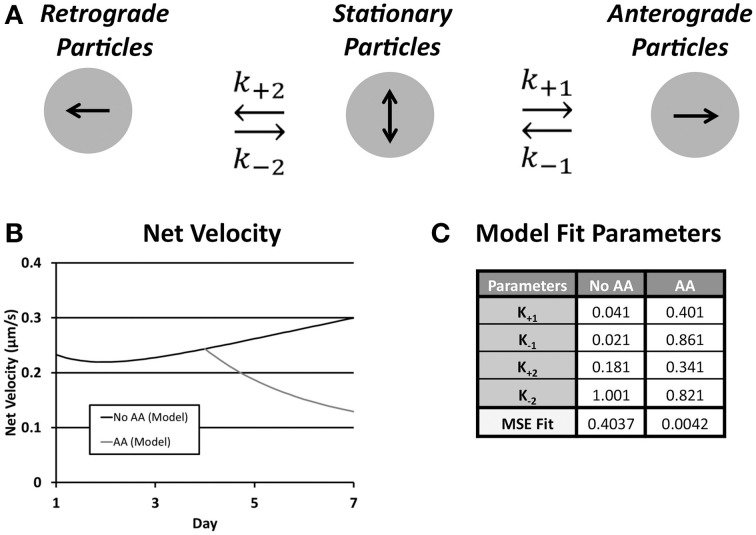
(A) Schematic of the rate kinetic model shows possible particle states and transition rate constants between the three states; (B) Plot of net velocity from optimized model output; (C) Following ascorbic acid treatment the rate of conversion from anterograde to stationary (k−1) as did the conversion rate from stationary to both anterograde (k+1) and retrograde (k+2) increased resulting in an overall reduction in net velocity. MSE fit agreement was strong in both treatment groups.